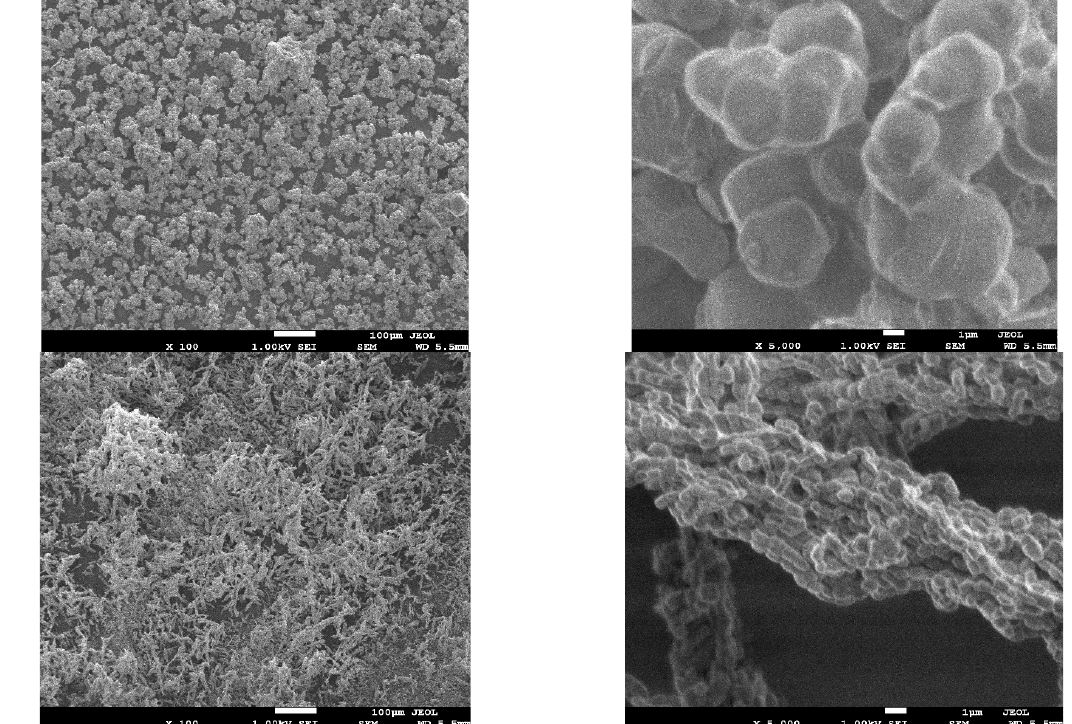
Figure 2. SEM images of of SBA ‒ 16 ( above ) and SBA ‒ 15 ( below ). Figure 2. SEM images of of SBA-16 ( above ) and SBA-15 ( below ).